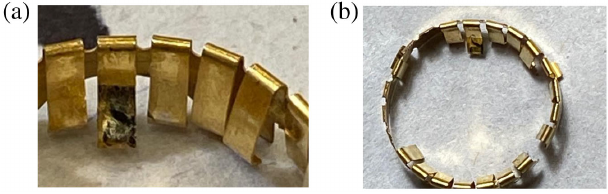
FIG. 6. (a) Spring finger element. One of the fingers clearly shows a burn mark. (b) Shows the plastic deformation of the spring finger being “ pulled forward ”